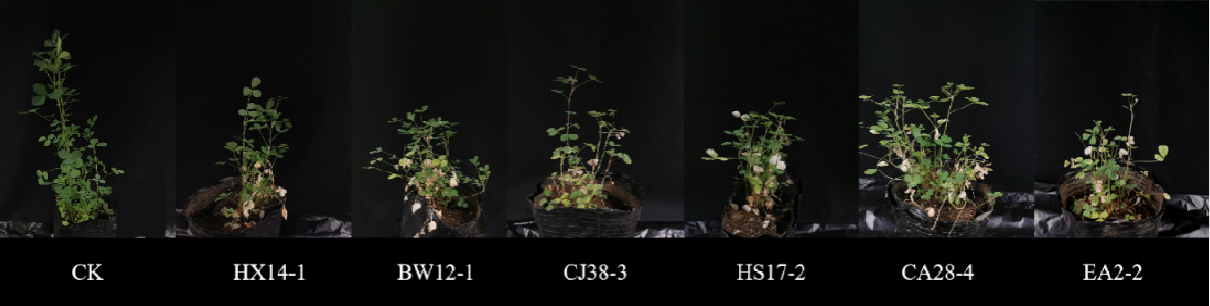
Figure 4. The symptoms of alfalfa seedlings 35 days after inoculation with Fusarium spp. Strains.